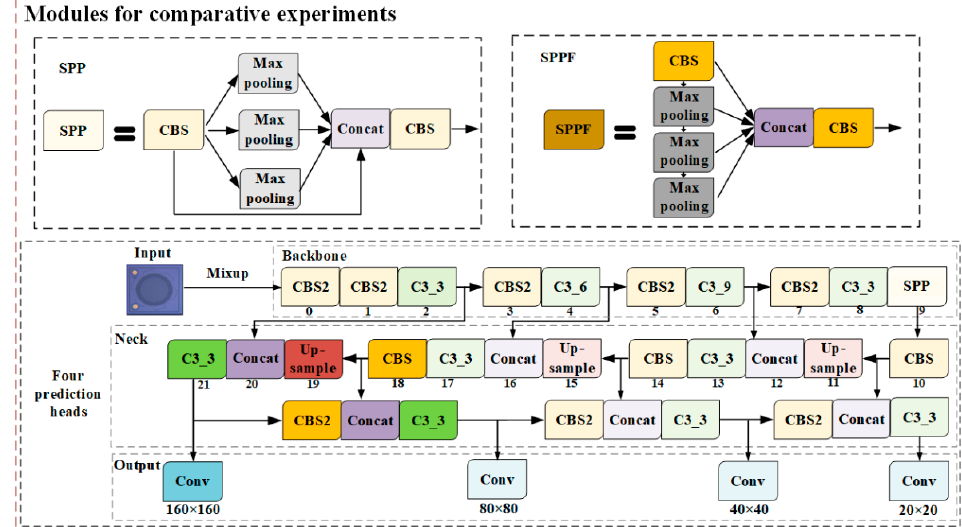
Figure 7. The modules for comparative experiments.